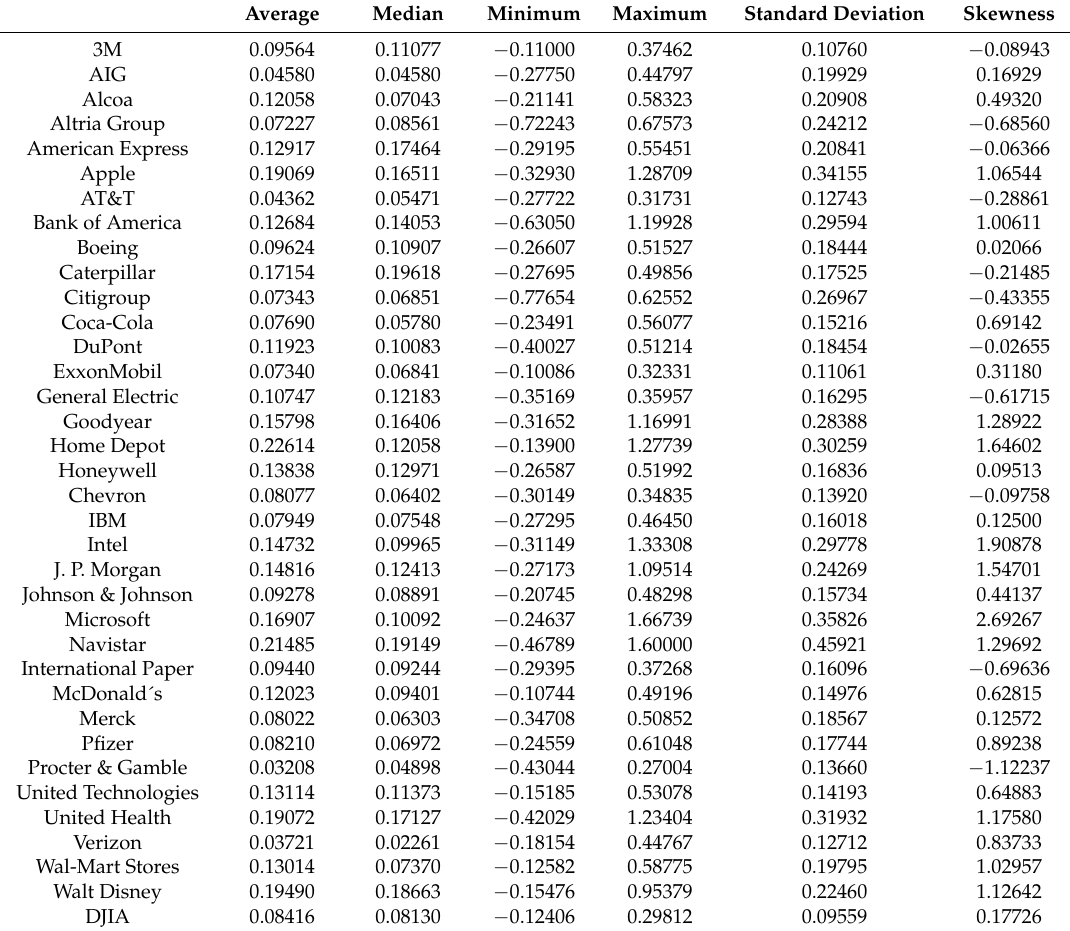
Table A3. Winter period returns—Descriptive